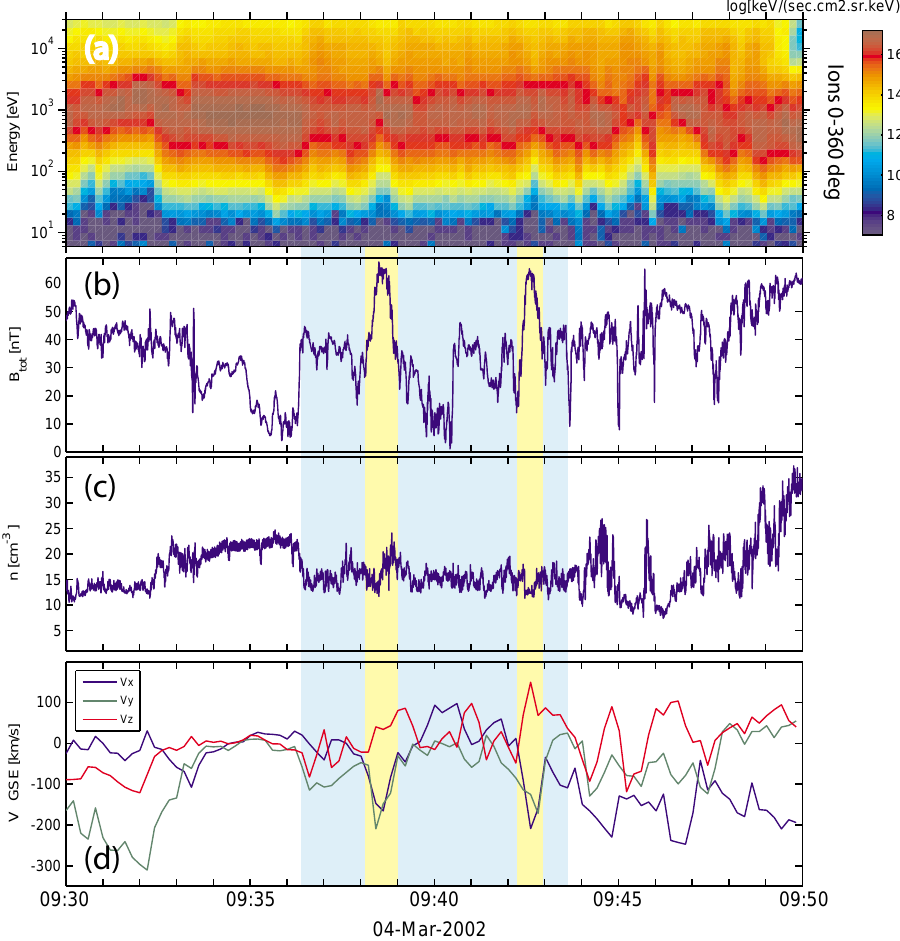
Fig. 2. Overview of the cusp/exterior cusp region observed by Cluster 3 during period 09:30–09:50 UT. Panels from top to bottom show: (a) ion spectrogram, (b) the magnetic field magnitude, (c) plasma density derived from the spacecraft potential, (d) ion flow velocity. The blue shaded region marks the time interval presented in Fig. 3. The yellow bars mark the